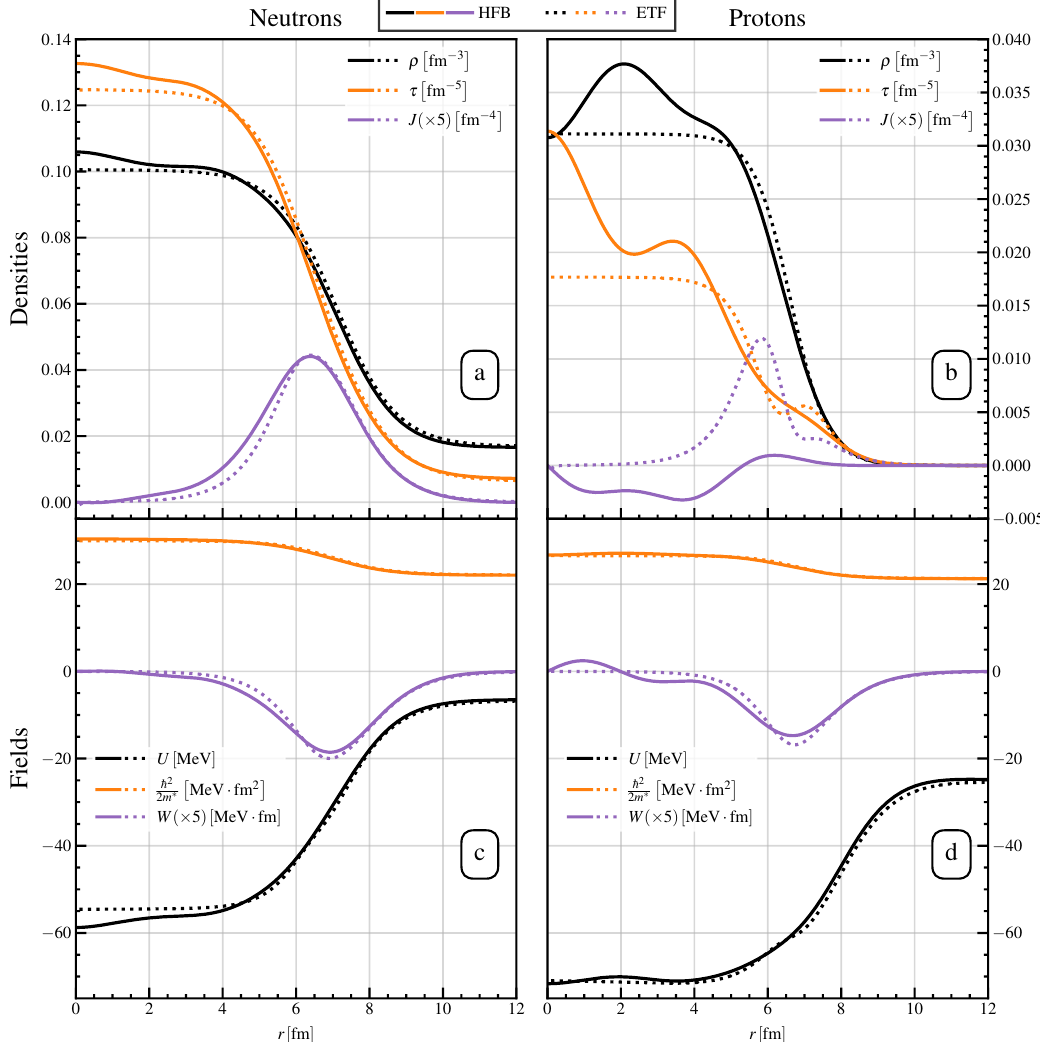
Figure 1. Densities (top row) and fields (bottom row), for neutrons ( left column ) and protons ( right column ), for a Wigner–Seitz cell with ρ b = 0.02 fm − 3 , Z = 40 and R WS = 24.0 fm. Black lines show the matter densities and central potentials; orange lines show the kinetic densities and effective masses; and purple lines show the spin current densities and spin-orbit fields. Solid lines show the results of using the HFB method, and dotted lines show those from using the ETFSI method; both used the SLy4 functional. Note the different scale used in panels a and b for the neutron and proton densities, to make clearer the bump observed in the proton densities; see the text for details. Note also that all spin current densities and spin-orbit fields are multiplied by 5 to make them more